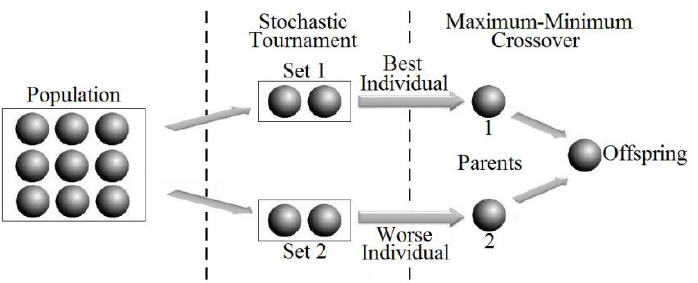
Figure 10. Selection and crossover in GA-MMC